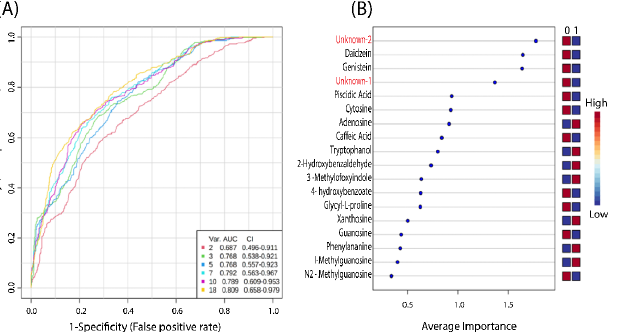
Figure 2. The comparison of different variables, as based on ROC curves. ( A ): The legend shows the feature numbers and the AUCs of the six models and ( B ): the average importance of 18 metabolites based on the ROC curves, in descending order of importance. The prediction of the model depends on the area under the curve (AUC) as provided by the ROC analysis — in other words, the greater the AUC, the better the prediction of the model.